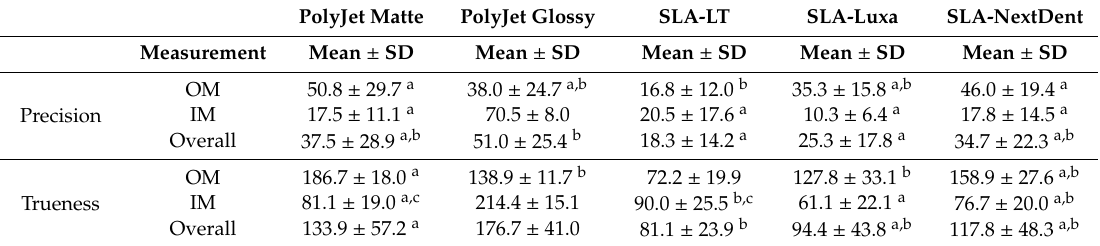
Table 4. Post-sterilization RMS values (mean ± SD) ( µ m) of precision and trueness for outer, inner, and overall measurements of test bodies fabricated using di ff erent biocompatible resin materials.